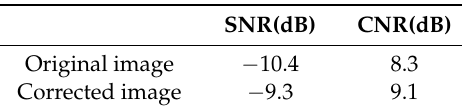
Figure 7. Ring artifact correction on a QUART phantom image taken with the Dexela 1512 FPD and evaluation of MTFs. ( a ) The original CT image obtained with the flat-field correction. ( b ) Its corrected image. ( c ) The difference image between ( a ) and ( b ). ( d ) Edge profiles at the rectangular ROI indicated by the solid lines in ( a ) and ( b ). ( e ) MTFs at the same ROI as in ( d ). Magnified images of the dashed ROI show effective ring artifact reduction in the uniform region. Table 1. Signal-to-noise ratios (SNRs) at the dashed region of interest (ROI) and contrast-to-noise ratios (CNRs) between Regions A and B in Figure 7.